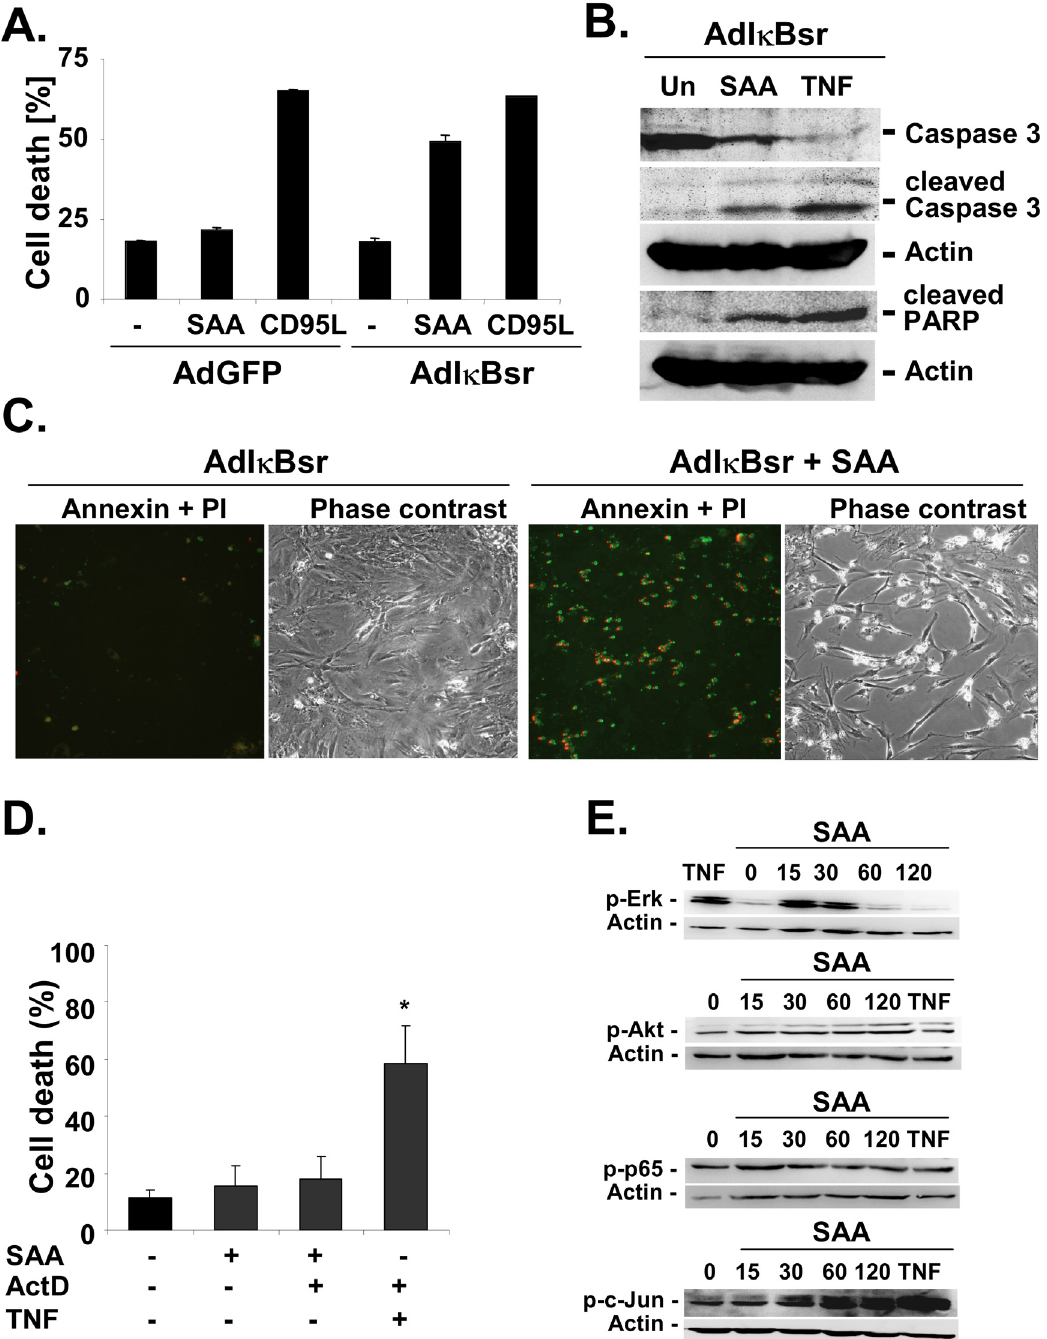
Fig 4. SAA induces apoptosis in HSCs after NF- κ B inhibition. Activated rat HSCs were infected with adenoviruses expressing either GFP or I κ Bsr. 24 hours later, HSCs were treated with rhSAA (5 μ M). A. After 18h or treatment, cell death was determined by LDH activity assay. B. Caspase 3 and PARP cleavage were determined by western blot analysis after 8 hours of rmSAA1 treatment. C. After 8 hours of rhSAA treatment, cells were stained with Annexin V (green) and propidium iodide (PI, red) to visualize apoptosis and necrosis. D. Primary mouse hepatocytes were serum-starved for 12h and treated with rmSAA (5 μ M), ActD (0.2 μ g/ml) or rmTNF α (30 ng/ml) for 18. Cell death was determined by LDH activity assay ( * p < 0.05 vs. untreated vehicle control). E. Primary mouse hepatocytes were treated with rmSAA (5 μ M) for the indicated times and rmTNF α (30 ng/ml) for 120 min. Phosphorylation of Erk, Akt, p65 and c-Jun was determined by western blot